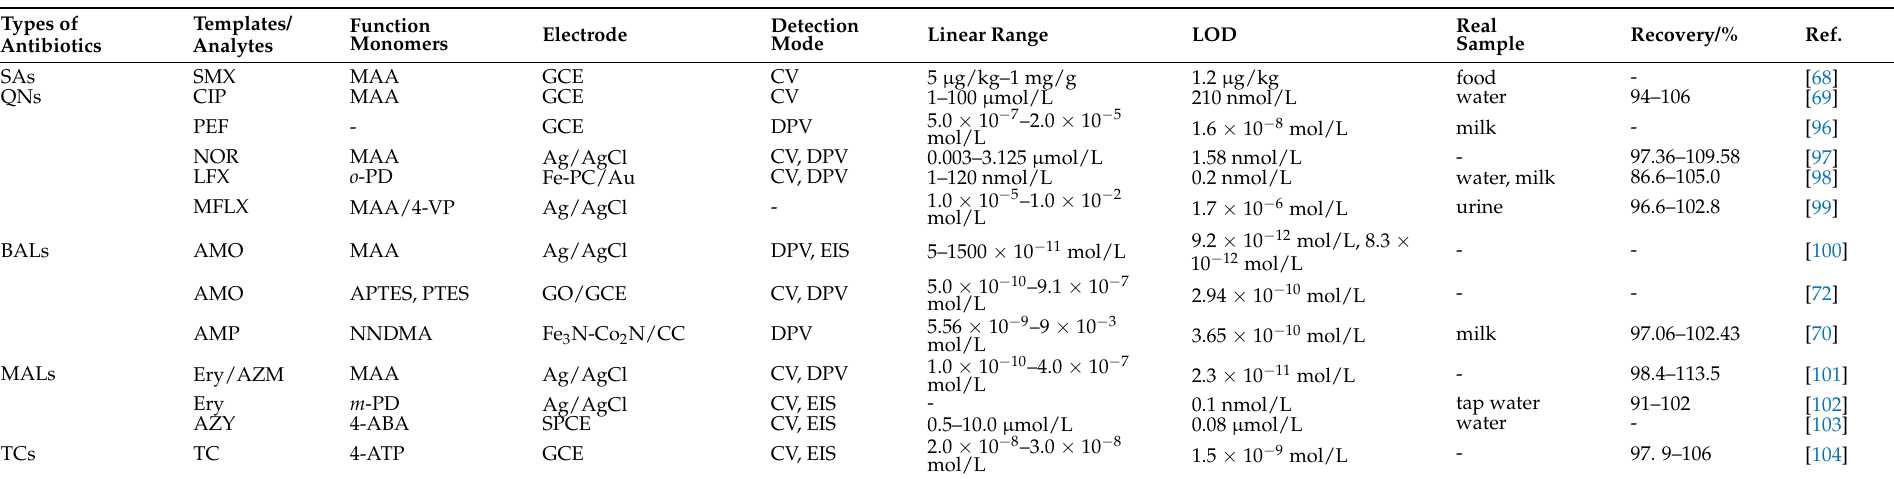
Table 2. Applications of MIP-based electrochemical sensors in antibiotic